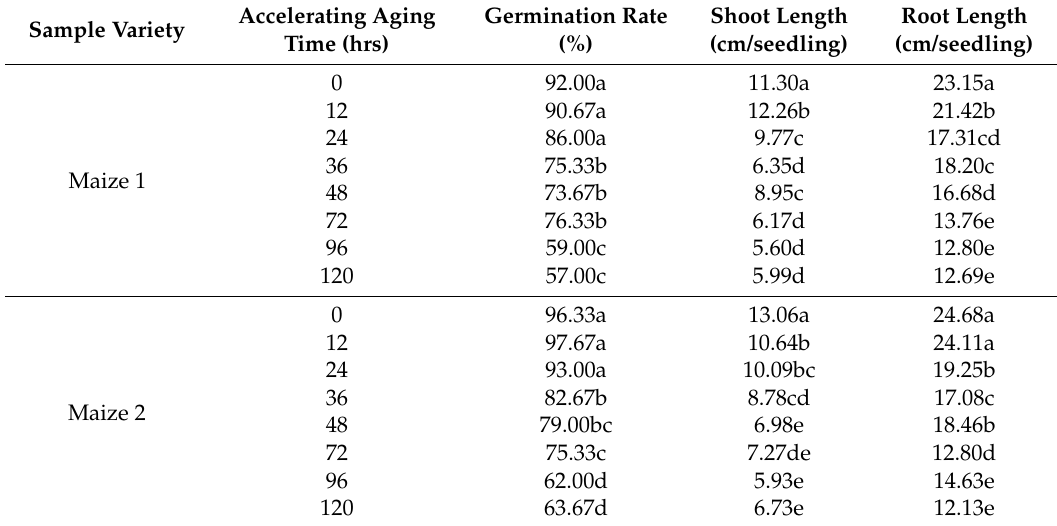
Table 8. Germination rate, shoot and root length of Maize 1 and Maize 2 under different accelerated aging